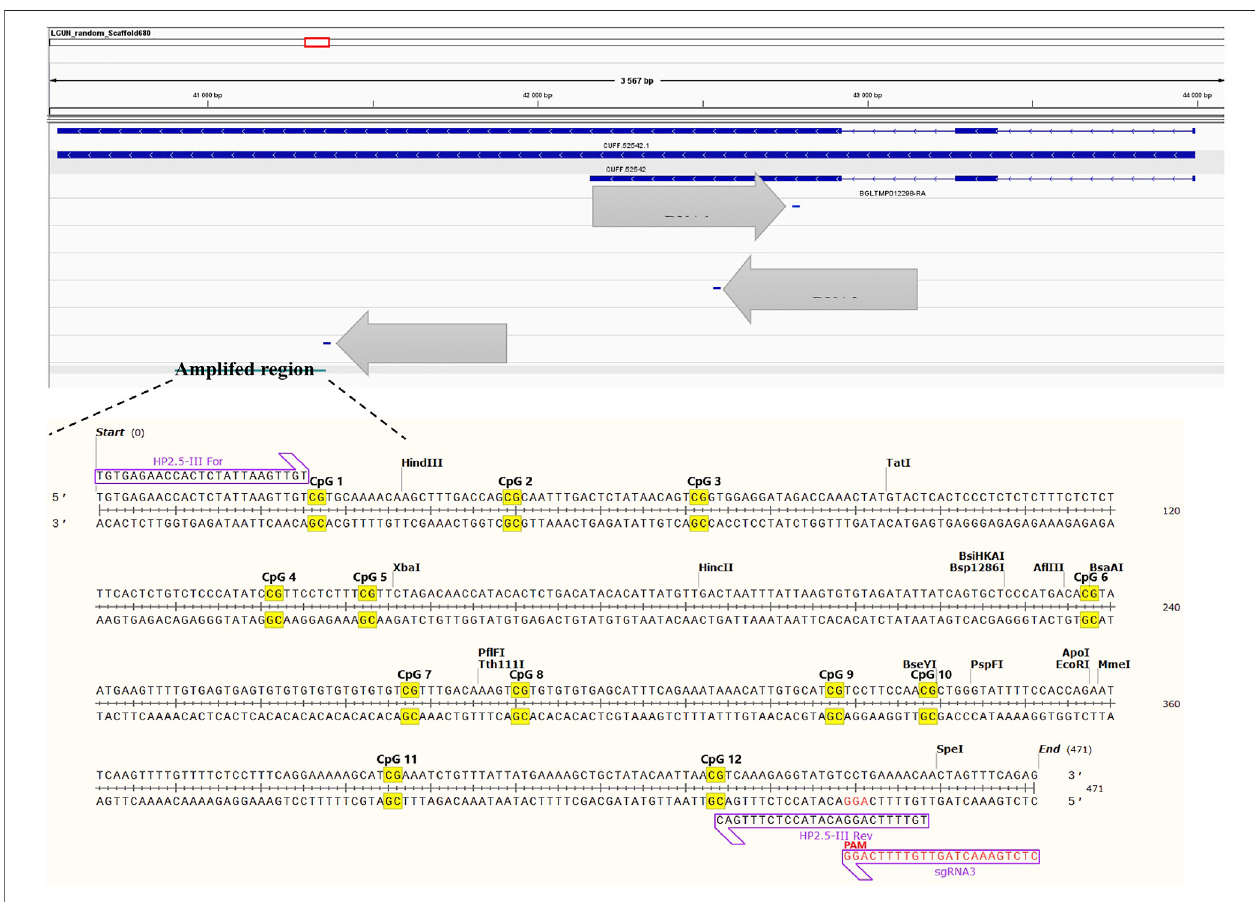
FIGURE 6 | sgRNA position at the targeted locus, whose genomic location is LGUN_random_Scaffold680:40914-41372. The target amplicon is within the gene body and contains 12 CpG sites. The complete sequence of each gRNA is found in the methods section.